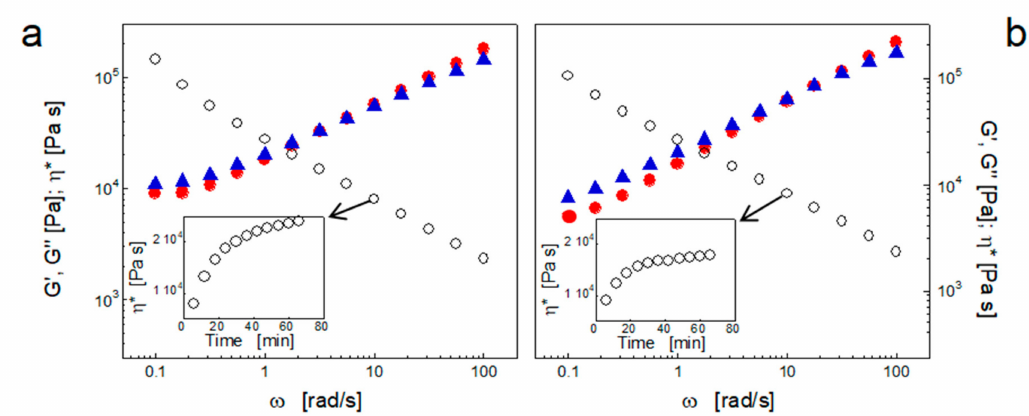
Figure 2. Frequency dependence of G’ (red circles), G” (blue triangles), and η * (empty circles) for PA11 TL ( a ) and PA11 P40 TL ( b ) at θ ≈ 10 ◦ C. The time evolution of G’ (red circles) and G” (blue triangles) at ω = 10 rad / s is shown in the insets.